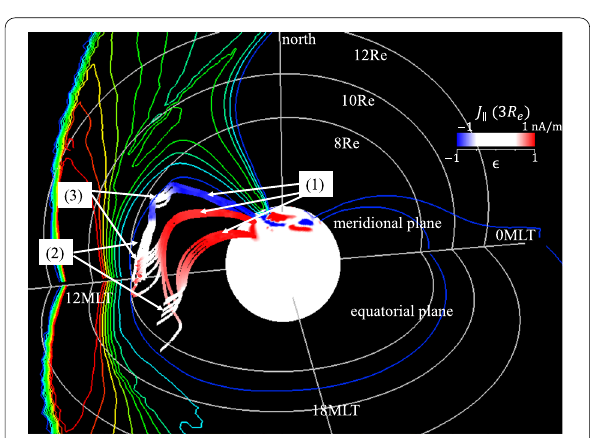
Fig. 12 The type H and L current systems illustrated in the same manner used in Fig. 3 at t 5.5 min according to the value of ǫ . The = current lines are shown only in the area of β <0.2. The Alfvén-mode current and the fast magnetosonic-mode current are dominant along the current lines denoted by (1) and (2), respectively. The mixture of the two modes appears along the current lines denoted by